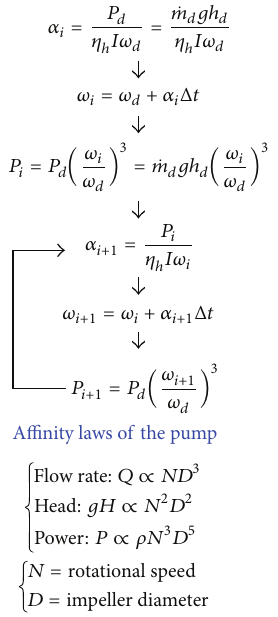
Figure 1: Calculation diagram of the